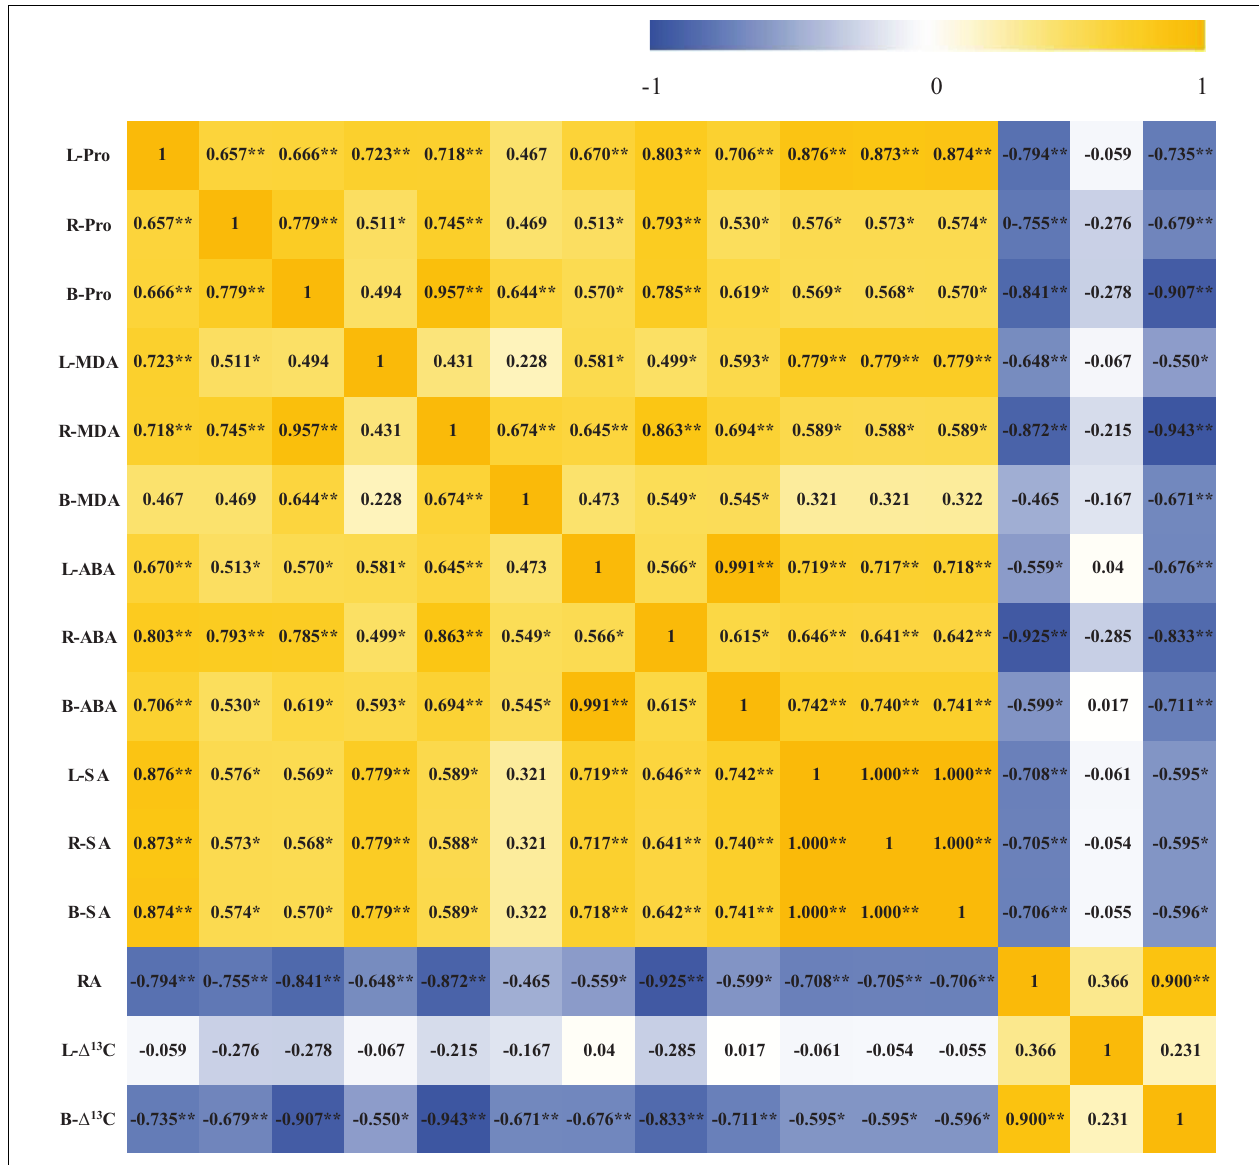
-0.735** -0.679** -0.907** -0.550* -0.943** -0.671** -0.676** -0.833** -0.711** -0.595* -0.595* -0.596* 0.900** 0.231